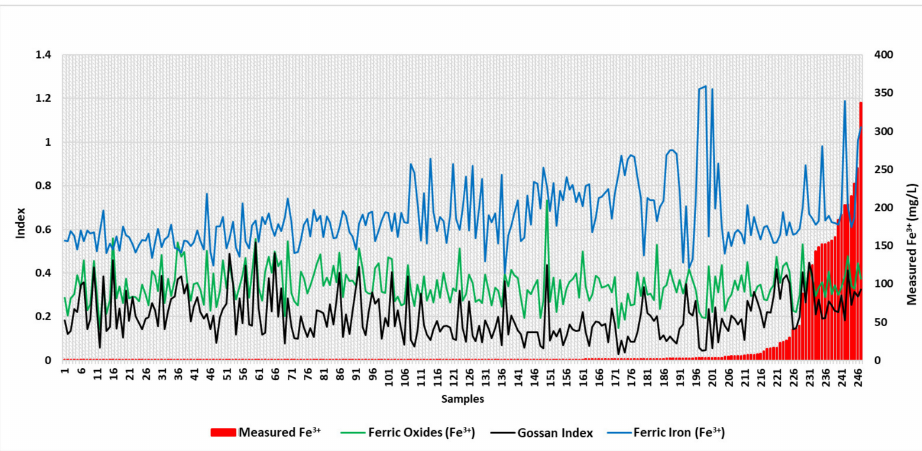
Figure 10. Comparison of Sentinel-2 indices and observed values of Fe 3+ concentrations from water analysis. The samples are ordered according to their measured Fe 3+ values.